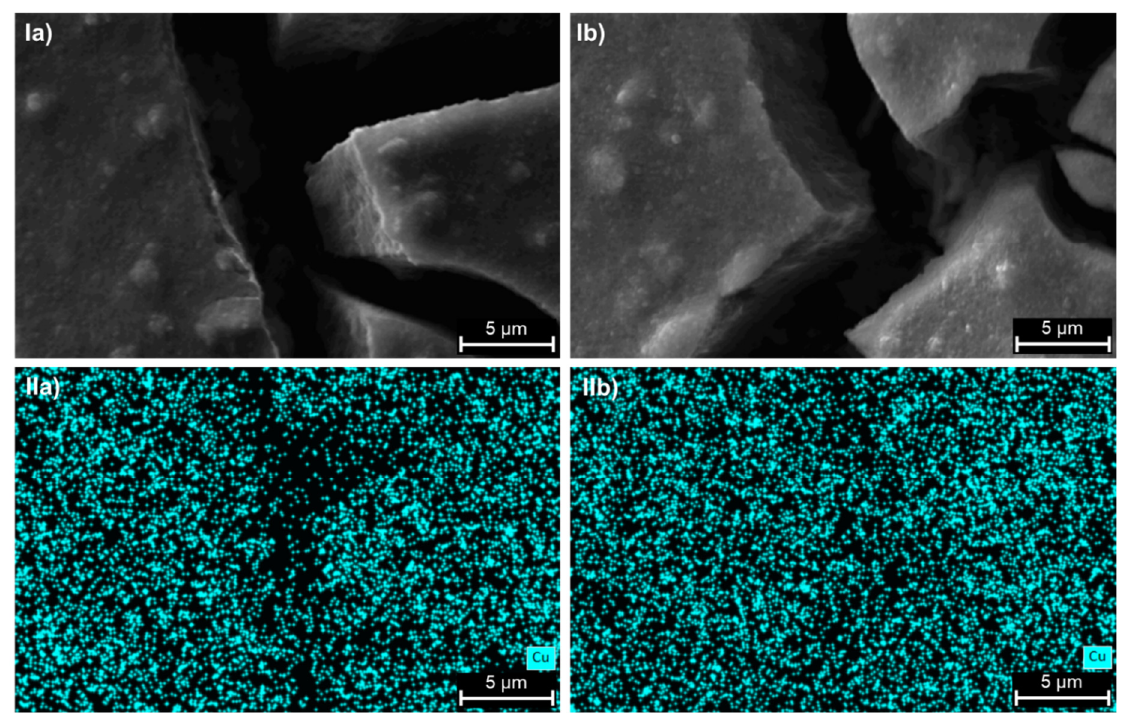
Figure 7. Environmental scanning electron microscopy images of copper ‐ doped P25 immobilized by spray coating ((x Cu = n Cu n Ti − 1 ≈ 2‰) on a rough steel substrate ( I ), U = 15 kV, I = 1.4 nA, high vacuum, 4k ‐ fold magnification; EDX element mapping of copper is given ( II ); comparison of two different preparation techniques: ( a ) impregnation before immobilization by spray coating; and ( b ) impregnation after immobilization by spray coating.